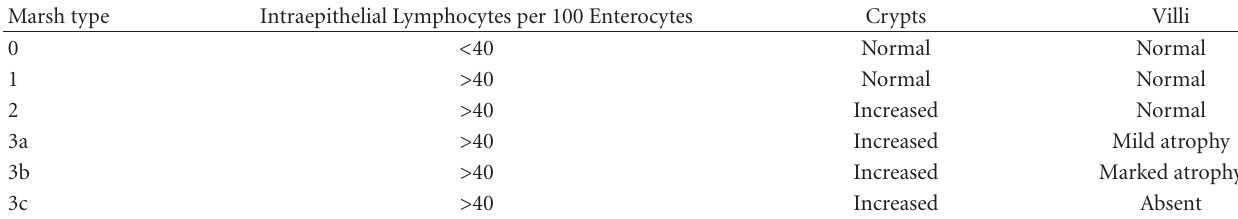
Table 1: Modified marsh classification of CD [11].